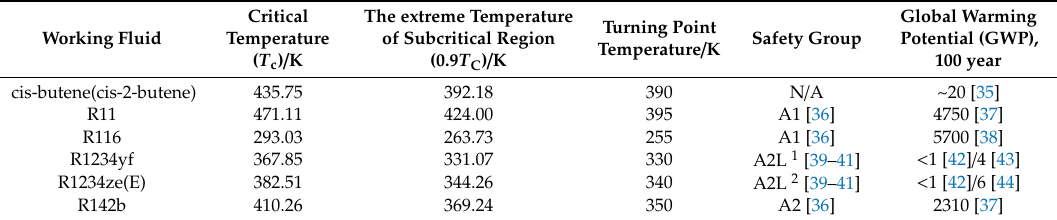
Table 1. Main thermodynamic, safety, and environmental properties of 6 working fluids. Critical The extreme Temperature Working Fluid Temperature of Subcritical Region ( T c ) / K (0.9 T C ) / K